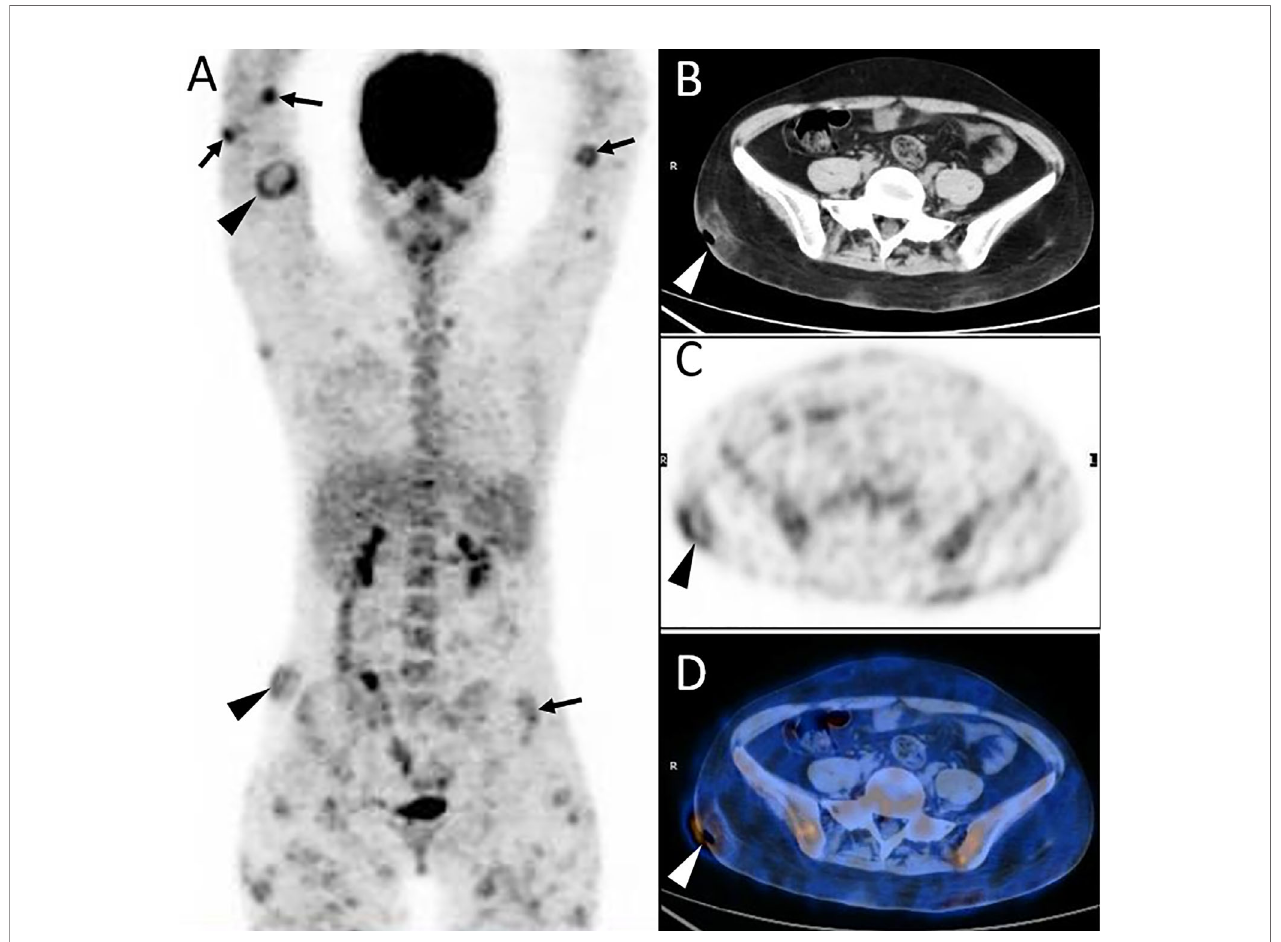
FIGURE 1 | Twenty-year-old female with subcutaneous panniculitis-like T-cell lymphoma (SPTCL). Three-dimensional maximum intensity projection PET image (A) shows multiple nodules and diffuse plaques with high uptake of 18 F-FDG in both upper arms and legs, lower back, and buttock. Multiple skin ulcerations with a maximum diameter of 10 cm present as circular uptake of 18 F-FDG (arrowheads) on PET/CT scan. Abdominal axial CT (B) , corresponding PET (C) , and fusion PET/ CT (D) images from 18 F-FDG PET/CT clearly show the defection of skin in the right hip, which represents ulcer caused by lymphoma involvement. This patient died 4 months after diagnosis of